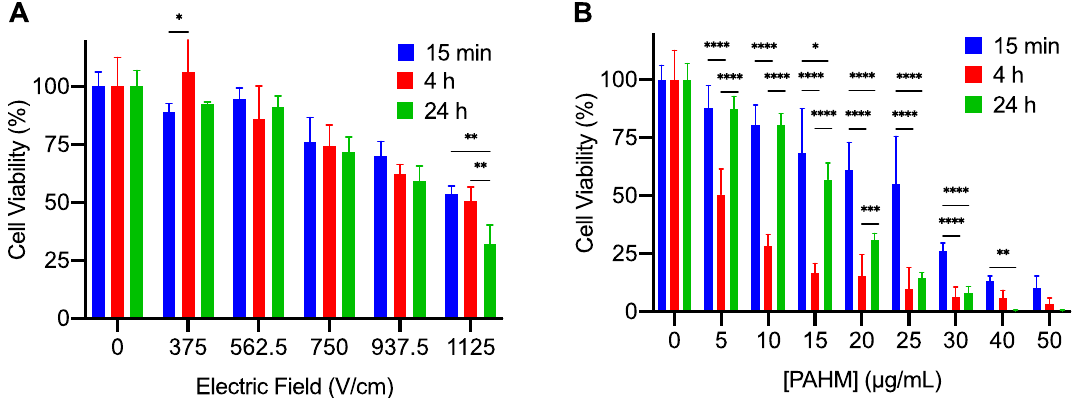
Figure 2. Cell viability after ( A ) IRE or ( B ) PAHM treatment applied separately. Data are shown as mean ± SD ( A ) (n = 4–6), ( B ) (n = 9–13). ANOVA with Tukey HSD test (*p < 0.05, **p < 0.01, ***p < 0.001, ****p < 0.0001).